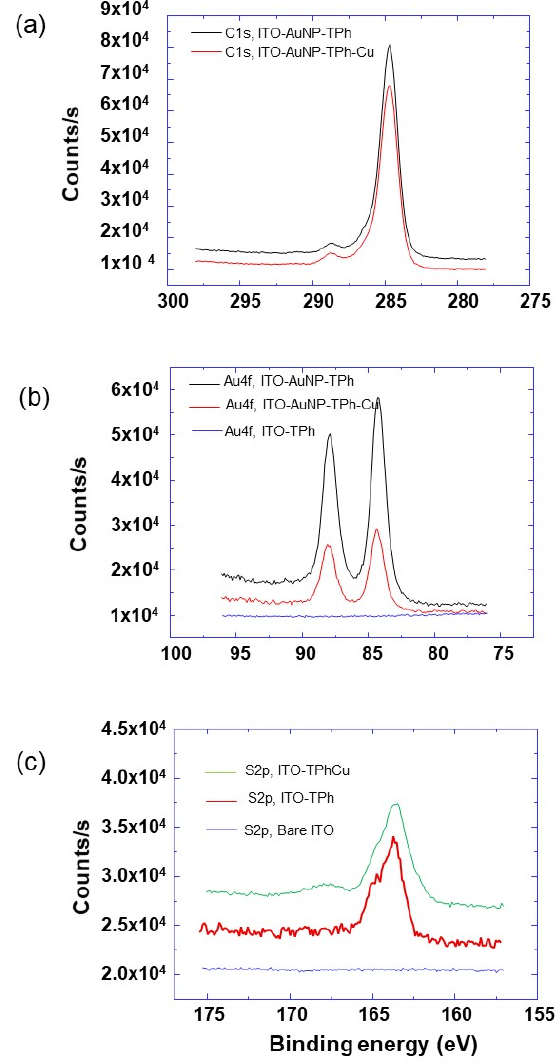
Figure 6. High-resolution XPS spectra of ( a ) C1s, ( b ) Au4f, and ( c ) S2p core level of the di ff erent modified electrode designs as indicated and in di ff erent situations: before and after electrode immersion into a Cu ions solution and after performing Square wave voltammetry (SWV) measurements.